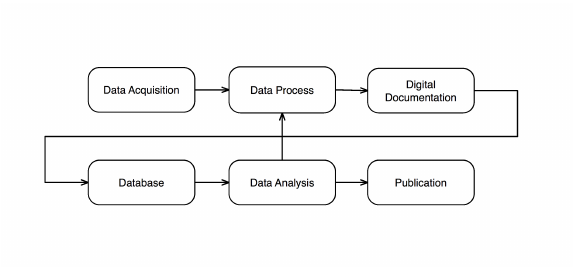
Figure 2: Framework